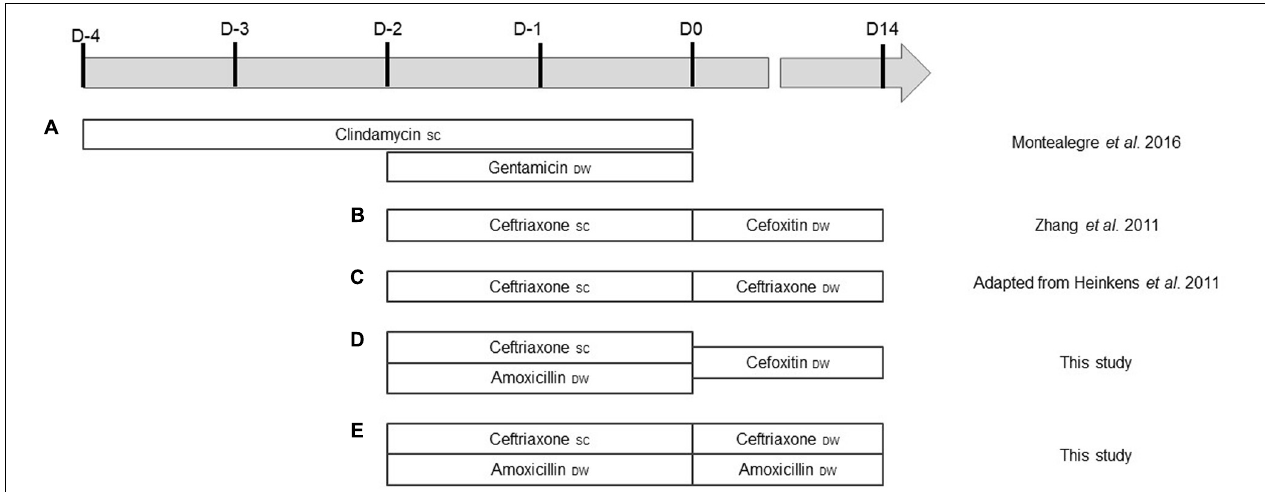
FIGURE 2 | (A–E) Antibiotic administration according to the different protocols. D0 corresponds to the day of bacterial suspension inoculation. SC, subcutaneous; DW, drinking water.